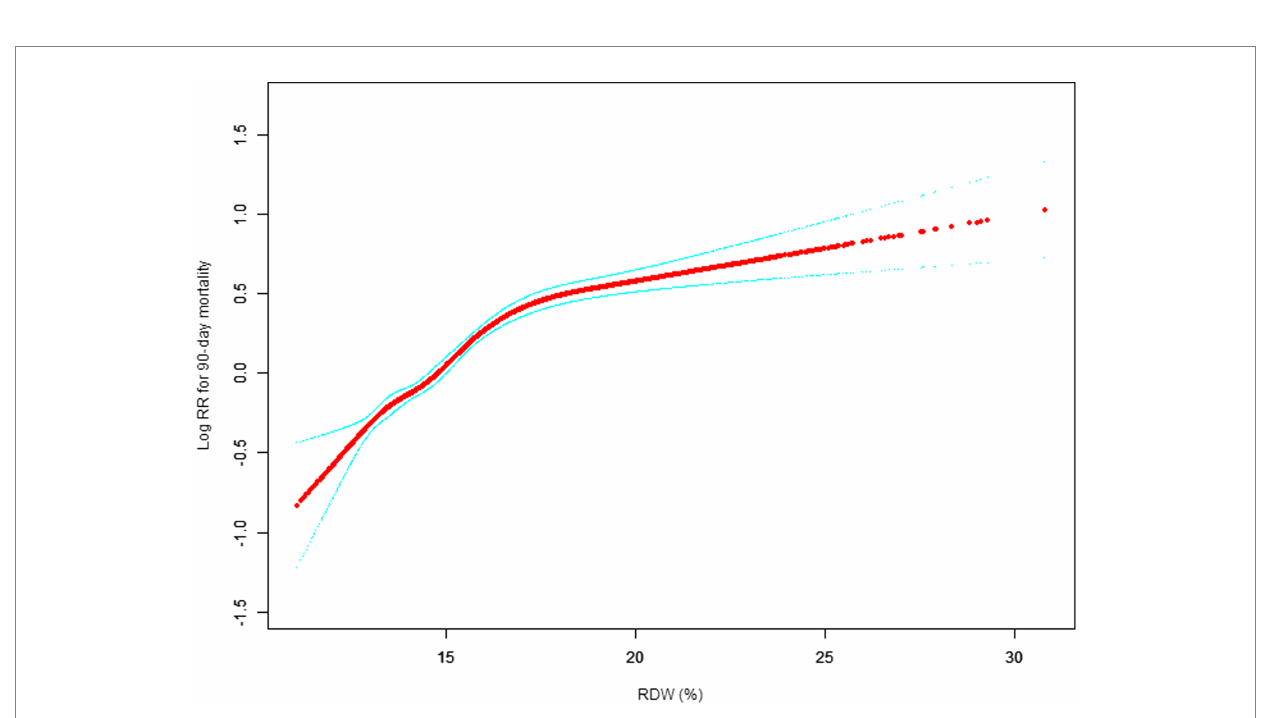
FIGURE 3 Association between RDW and 90-day all-cause mortality. (After adjustment for other covariates). A generalized additive model (GAM) revealed a threshold, nonlinear relationship between RDW and 30-day mortality. The smooth curve fit between variables is shown by a solid red line. The 95% confidence interval from the fit is represented by imaginary blue